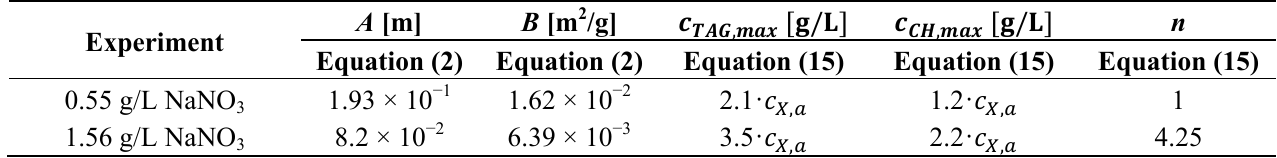
Table 2. Parameters of the validation